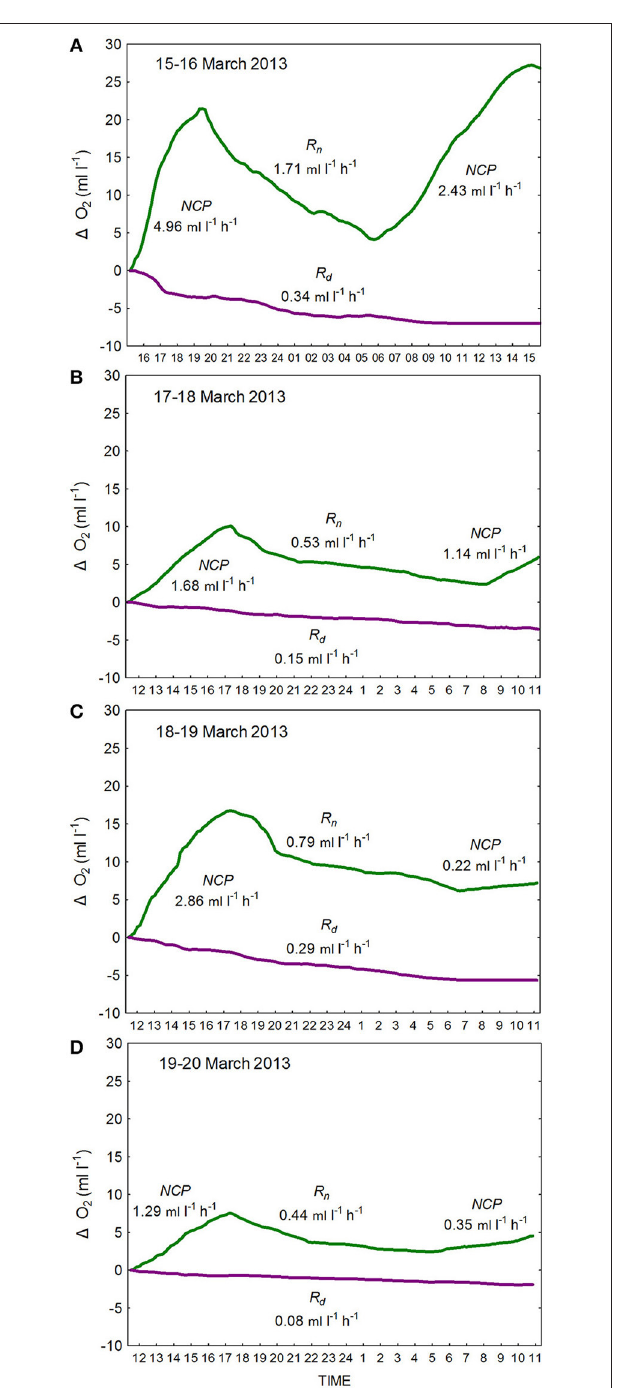
FIGURE 2 | Changes in O 2 concentrations as determined from continuous measures (10-min intervals) of oxygen in large-volume (10 l) light- (green line) and dark- (purple line) polycarbonate carboys as logged by RINKO-1 sensors from (A) 15–16 March 2013, (B) 17–18 March 2013 (C) 18–19 March 2013, and (D) 19–20 March 2013. Hourly rates of (1) net community production ( hourly-NCP ) were determined from increases in O 2 in the light bottle during the day, of (2) community respiration ( hourly-R n ) as determined from the decrease in O 2 concentration in the light bottle at night, and of (3) net community respiration ( hourly-R d ) as determined from the decrease in oxygen in the dark